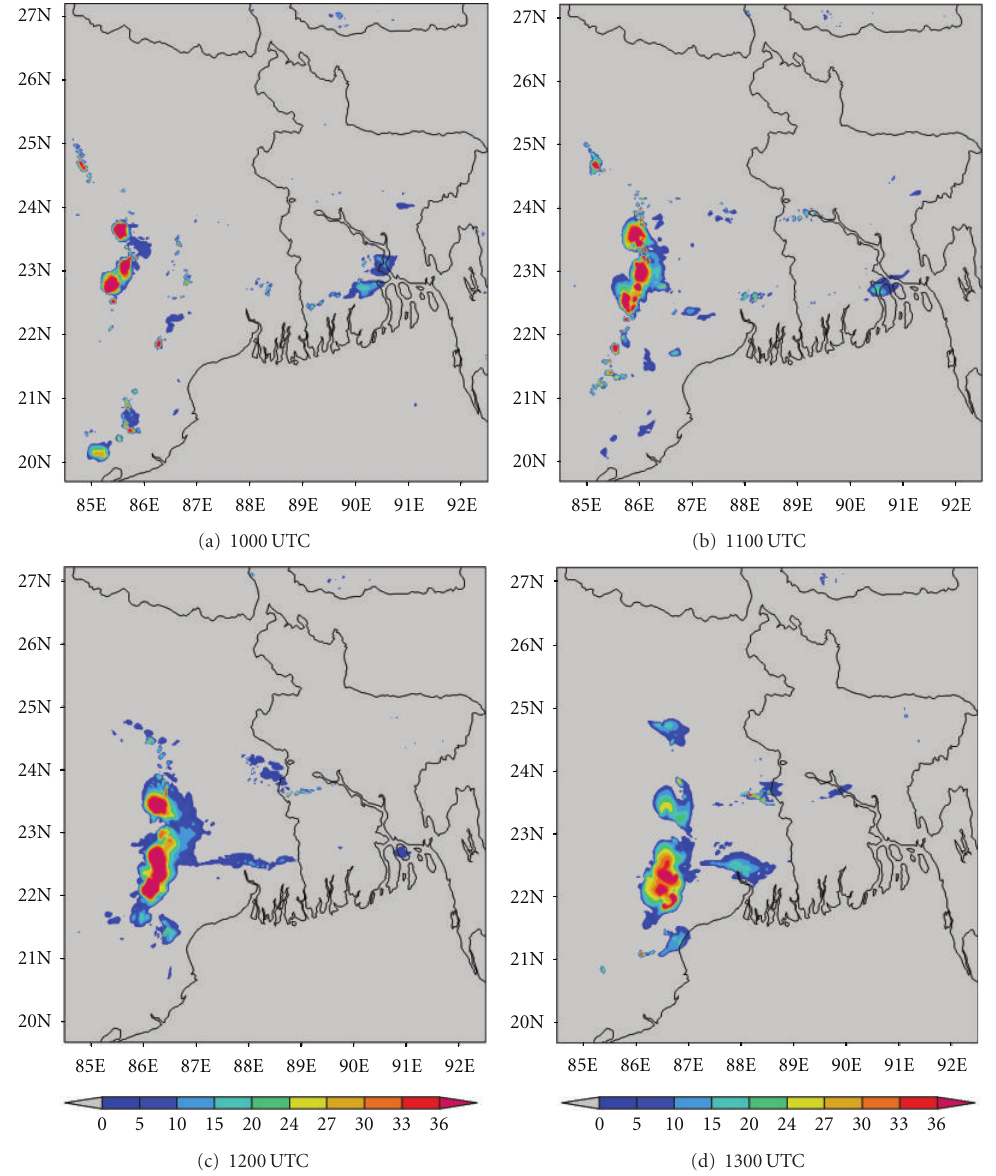
Figure 12: ARW-model-simulated composite radar reflectivity (dBZ) from 1000 to 1300 UTC on 15, May,